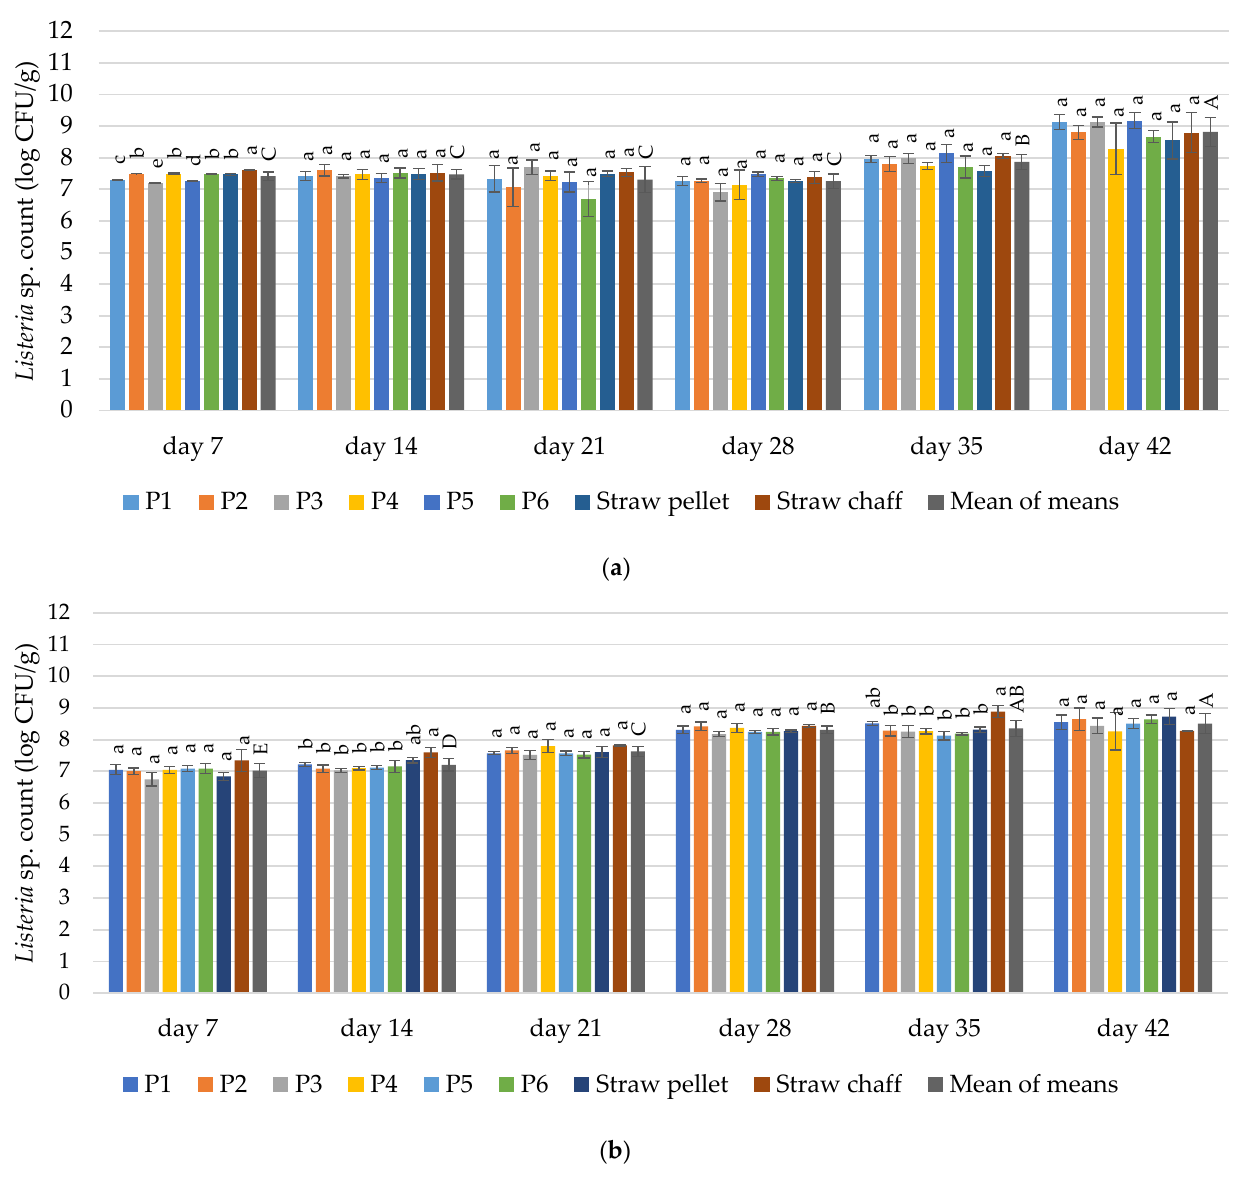
Figure 6. Changes in the count of microorganisms of Listeria sp. in the tested bedding materials: ( a ) 1st experimental cycle; ( b ) 2nd experimental cycle. All values are means of three independent replicates ± SD, except the last bars for each day, which are the means-of-means. For each day, means with a common lowercase letter are not significantly different by the Tukey test at the 5% level of significance. For different days, means-of-means with a common uppercase letter are not significantly different by the Tukey test at the 5% level of significance. Pairwise comparisons between materials are presented only for observations from the same day. Pairwise comparisons between days are presented only for means-of-means. No pairwise comparisons between cycles are presented.